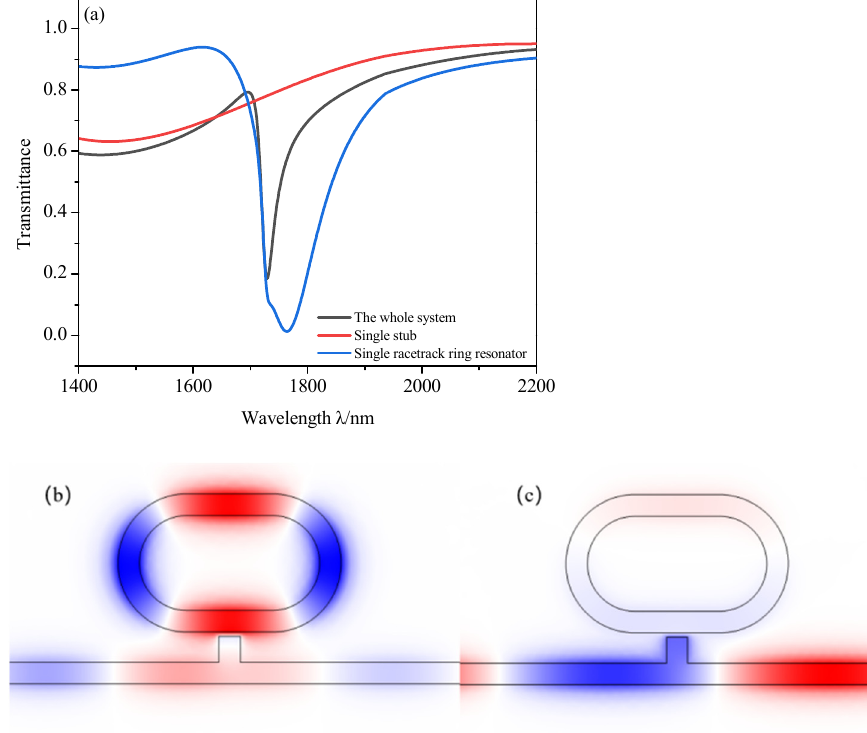
Figure 1. The geometric structure of the coupled racetrack ring resonator .